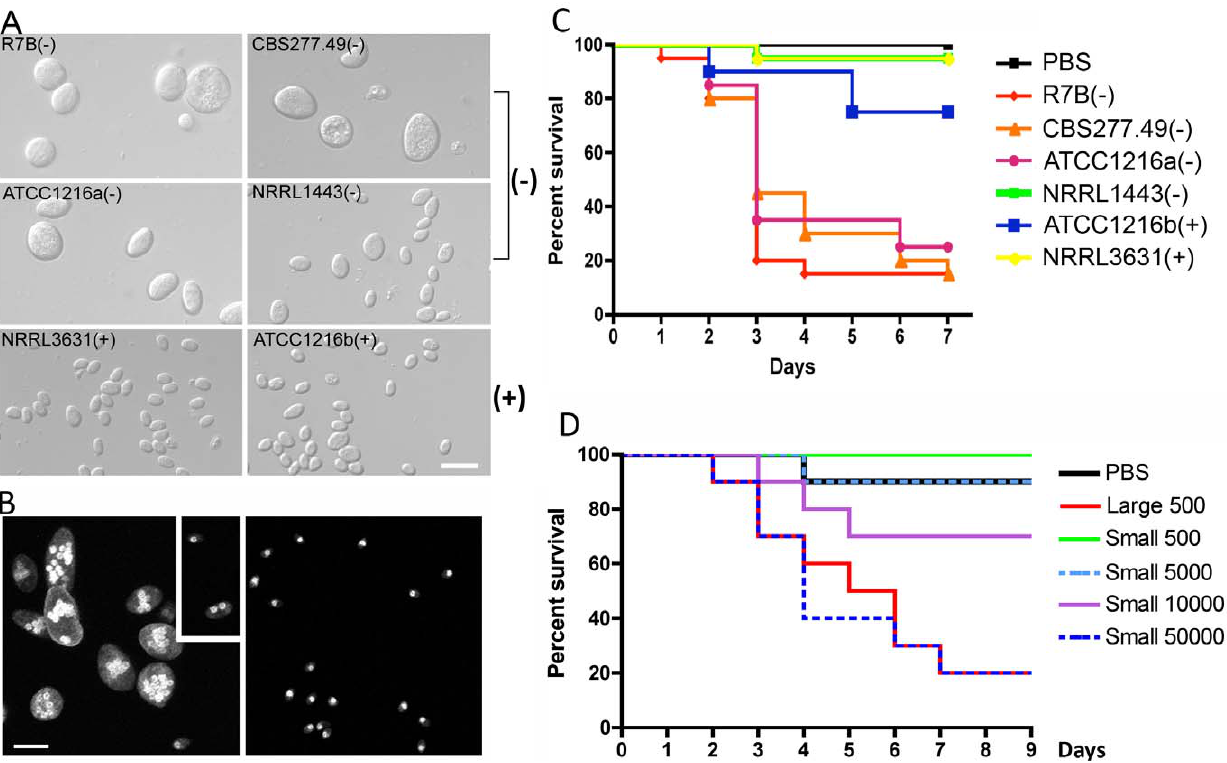
Figure 1. Correlation between spore size and virulence in M.c. f. lusitanicus . (A) Several strains of Mcl display differences in spore size. Two ( 2 ) strains (R7B and ATCC1216a) produce larger spores (12.32 6 2.71 m m long for R7B), and two ( + ) strains (NRRL3631 and ATCC1216b) produce smaller spores (4.70 6 0.91 m m long for NRRL3631). One ( 2 ) isolate, NRRL1443, produces intermediate sized spores. Note that R7B is an auxotrophic mutant (leucine 2 ) of CBS277.49 and the mutation in the leuA gene did not impact virulence. (B) Nuclei were stained with DAPI and cell walls were stained with calcofluor. Combined Z-stack images show a difference in the number of nuclei in the ( 2 ) and ( + ) mating type spores. The left panel shows multinucleated spores; however, smaller spores of the ( 2 ) mating type (small rectangular area) are uni- or bi-nucleate. The ( + ) spores in the right panel are uninucleate. Scale=10 m m. N.A.=1.4 with oil. (C) Virulence in the wax moth host is correlated with spore size. Three ( 2 ) strains (R7B, CBS277.49, and ATCC1216a) are significantly more virulent compared to the ( + ) strains with a smaller spore size (see the text for statistics). (D) In the survival curves of wax moth larvae infected with different numbers of ( + ) spores (NRRL3631), only 50,000 ( + ) spores are similarly virulent to 500 ( 2 ) spores (R7B) ( p =0.8826). See Figure 1S for the analysis of additional large ( 2 ) and small ( + ) sporangiospore producing strains further substantiating the link of spore size to virulence.